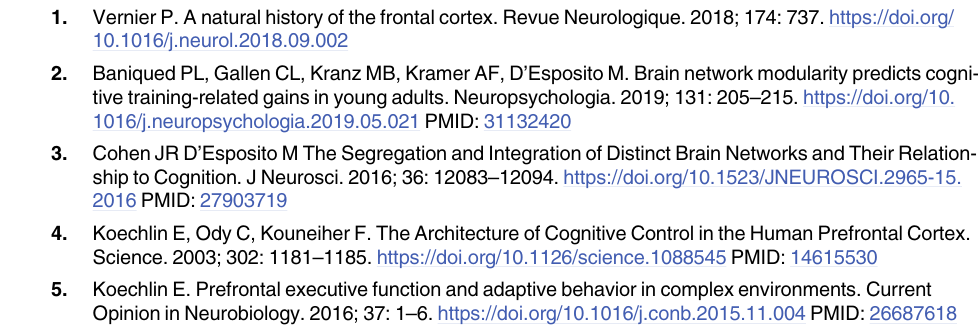
S5 Fig. Causal pattern space of DCM for fMRI data. A. Illustration of the model space for Bayesian model selection. We specified six models to determine whether the feedforward, feedback or both connections between OFC were modulated by the strategy switching. We constrained the space to models with assumed dlPFC to MD reciprocal connections as the role of these connections have been demonstrated in animal studies [21]. Bayesian model selection revealed that among the models with the tactile input directed to dlPFC, model 3 was superior to the other 5 models. B. The log-evidence and posterior probability for each of the 6